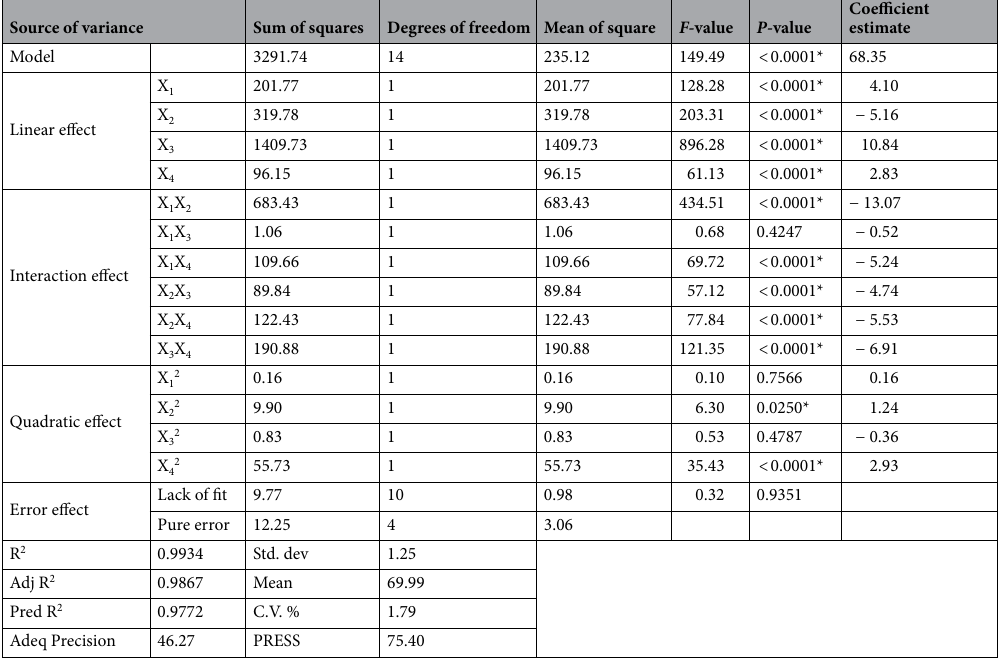
Table 4. Analysis of variance for simultaneous biosorption of copper (II) ions by using Fucus vesiculosus. F Fishers’s function, P level of significance, C.V. coefficient of variation. *Significant